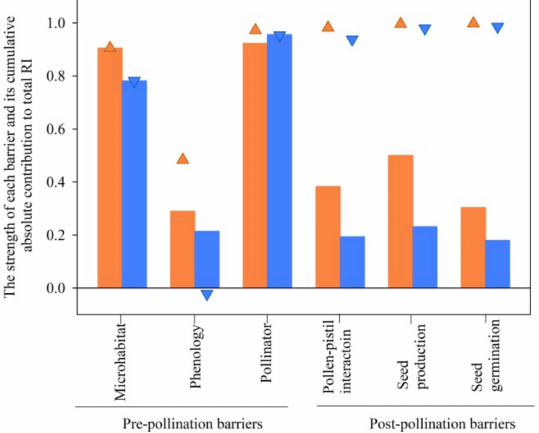
Figure 6. The degree of six barriers (bars) and their accumulative absolute contributions (triangle symbols) to total isolation in reciprocal crosses of the two species. Bars and triangle up symbols with coral color represent S . digitaloides , while bars and triangle down symbols with blue color represent S . flava